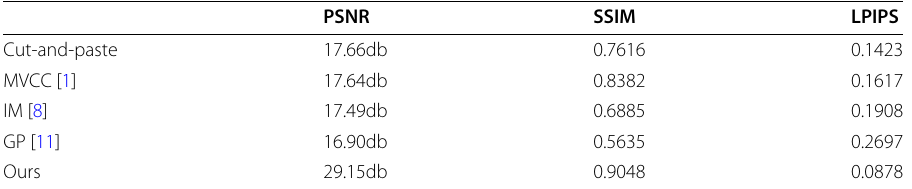
Table 4 Comparisons of methods on the AMOS test dataset PSNR SSIM LPIPS Cut-and-paste 17.66db 0.7616